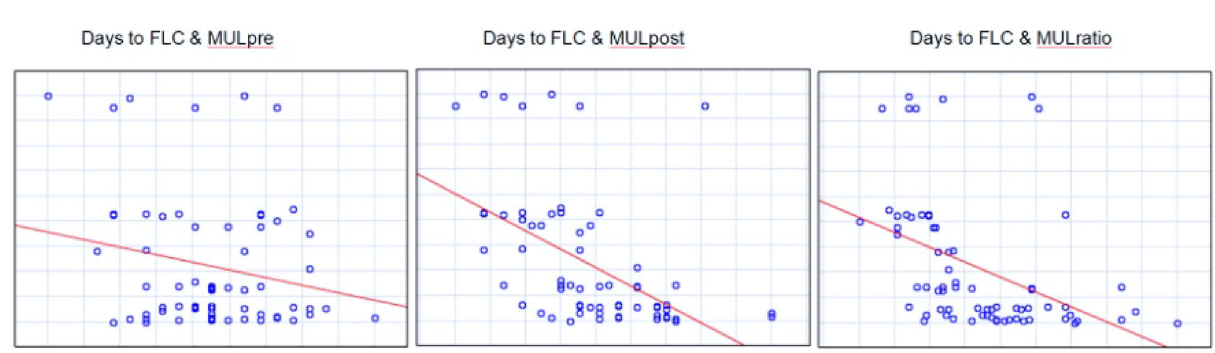
Figure 7. Spearman’s rank correlations test between membranous urethra length measured preoperatively (MULpre), postoperatively (MULpost) and percent change of membranous urethra length (MULratio) and time to continence recovery—days to final level of continence (Days to FLC) in the group of patients continent 12 months after laparoscopic radical prostatectomy. Strongest statistically significant inverse correlation (R—0.6, p < 0.000005) was shown between MULpost and time to continence recovery in cumulative 12 months follow-up